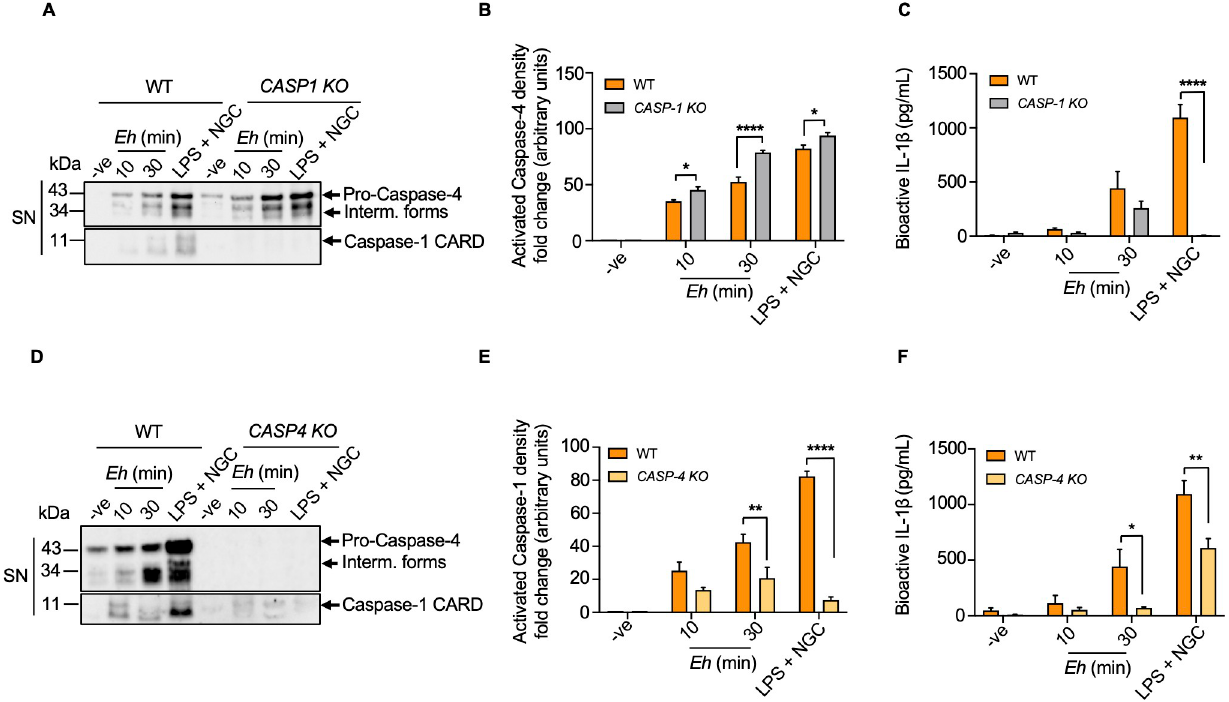
Fig 4. E . histolytica -induced caspase-4 activation is enhanced in the absence caspase-1. ( A, B ) WT and CRISPR/Cas9 CASP1 KO macrophages were stimulated with Eh for 10 and 30 min and unstimulated cells were used as an internal control. Macrophages stimulated with LPS (50 ng/mL) and NGC (10 μ M) was used as a positive control. Quantifications of active caspase-4 protein were performed by densitometric analysis and negative (cells only) acted as an internal control. Statistical significance was calculated between WT and CASP1 KO macrophages at each time point ( C ) Bioactive IL-1 β secretion in the histogram was quantified by the SEAP assay and statistical significance was calculated between WT and CASP1 KO macrophages at each time point. ( D, E ) WT and CRISPR/Cas9 CASP4 KO macrophages were incubated with Eh (20:1) at increasing time points. Caspase-1 CARD densitometry was measured and statistical significance was calculated between WT and CASP4 KO macrophages at each time point. Cell supernatant (SN) was TCA precipitated and equal amount of cell supernatants was loaded onto SDS-PAGE and immunoblot analysis was performed for caspase-4 and caspase-1. Active caspase-1 was quantified by densitometric analysis, and negative (cells only) acted as an internal control. ( F ) Cell supernatant was added to HEK-Blue IL-1 β reporter cells to detect bioactive IL-1 β secretion via measuring the SEAP and statistical significance was calculated between WT and CASP4 KO macrophages at each time point. Data and immunoblots are representative of at least three separate experiments (n = 3) and statistical significance was calculated with with Student’s t-test between KO and WT, ( � p < 0.05, �� p < 0.01, ���� p < 0.0001). Bars represent mean ± SEM.